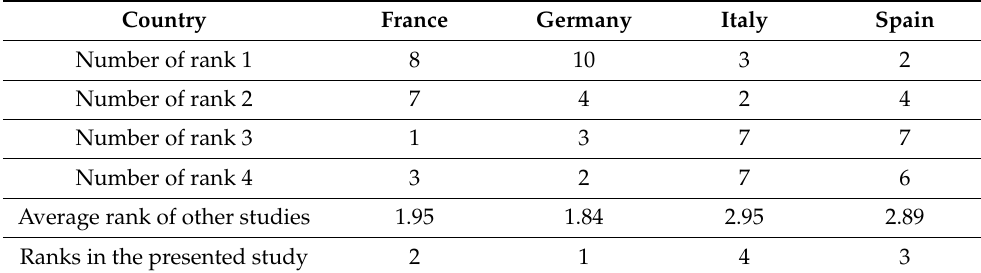
Table 6. Comparison of country ranks considering estimates of energy security. Source: own